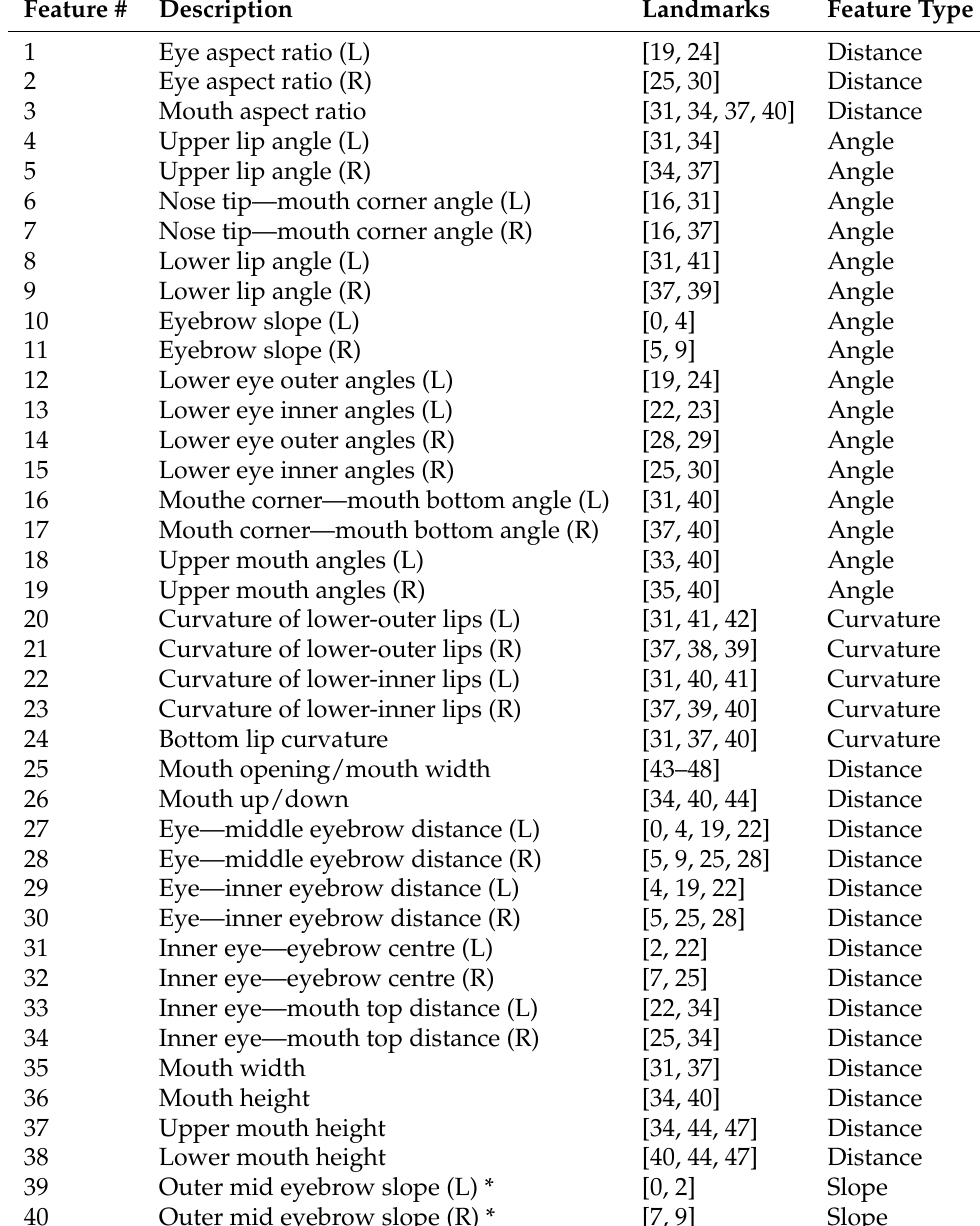
Table A2. The full geometric feature set. * indicates the feature was added here and not used in the original paper. Distance based features are normalized by face height. Landmark numbers can also be found in Figure